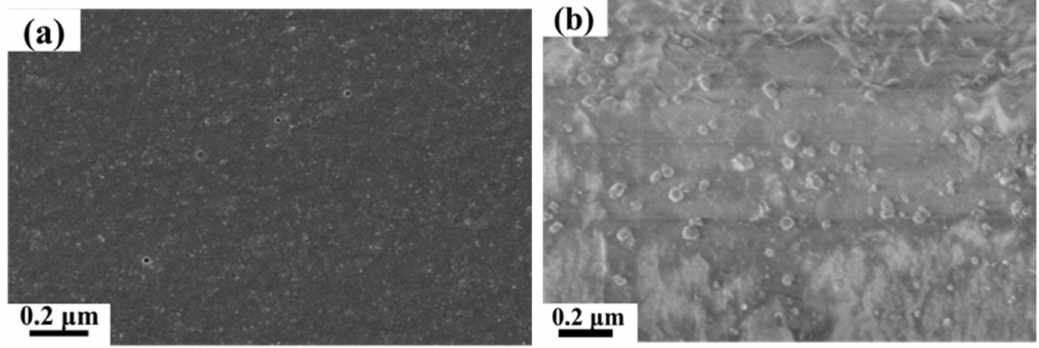
Figure 5. ( a , b ) SEM images of composite coatings Z3 and Z5.